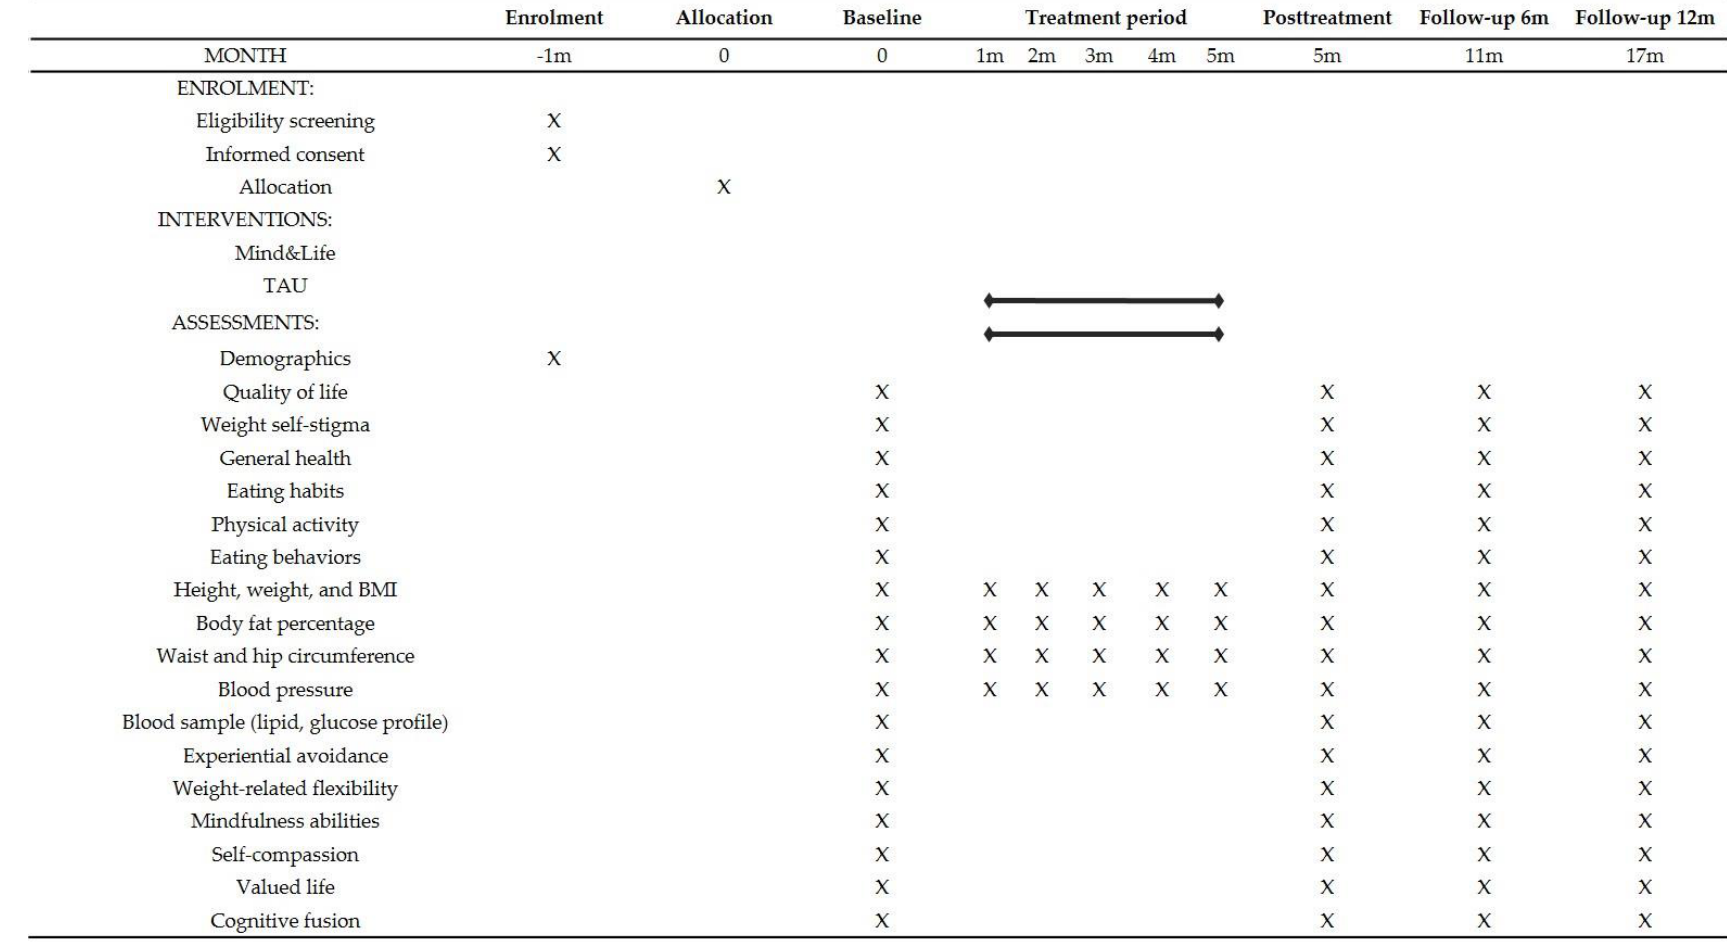
Figure 1. SPIRIT flow diagram: Schedule of events for the Mind&Life study.